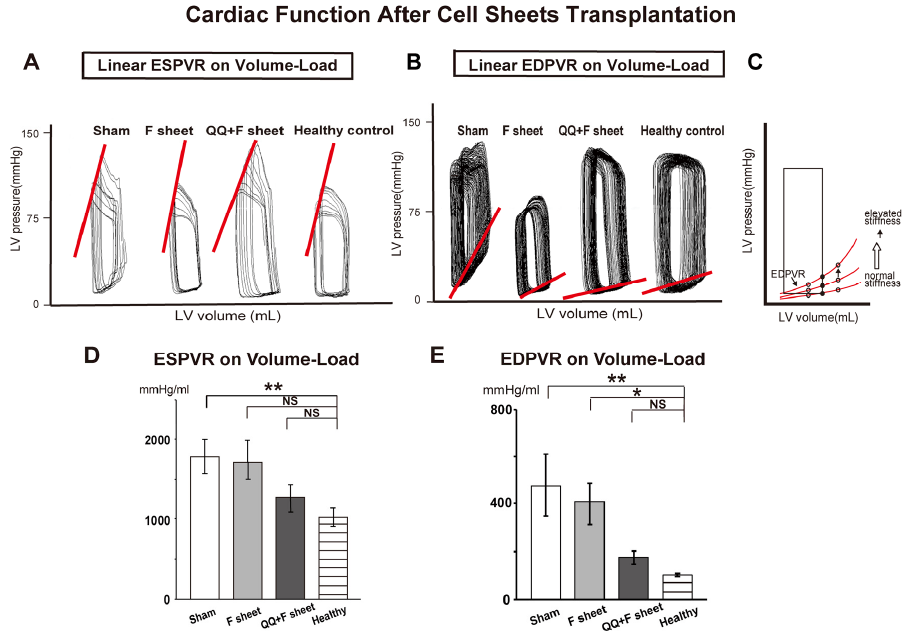
Figure 6. Cardiac function on 15 days after transplantation of QQ+F sheets derived from EAM rats. Cardiac functions were recorded using a conductance catheter and the pressure–volume (P-V) loop was measured as described in Methods. ( A , B ) Representative P-V loops on 14 days after cell sheet transplantation. ( A ) The oblique lines indicate end-systolic pressure–volume relationship (ESPVR). ( B ) The oblique lines indicate end-diastolic pressure–volume relationship (EDPVR). ( C ) An sche- matic diagram showing hypothetical EDPVR. EDPVR describes LV compliance. A decrease in LV diastolic function owing to a decrease in cardiac compliance is indicated by an upward shift in EDPVR. ( D ) The ESPVR on volume load showed significant differences between sham and healthy control groups. N = 6 rats per group. ( E ) The EDPVR on volume load were significantly higher in the sham and F-sheet groups than in the healthy control group. There was no significant differences between the QQ+F sheet and healthy control groups. N = 6 rats per group. Data are shown as mean ± SE. NS, not significant, * p < 0.05, ** p < 0.01, vs. healthy control group. 3.6. QQ+F Sheets Grafts in EAM Hearts Inhibited the Bnp Gene Expression Indicating HF BNP is considered a diagnostic and prognostic biomarker for HF [37]. Bnp mRNA levels in the heart at 14 days after sheet transplantation were significantly higher in the sham and F-sheet groups than in the healthy control group ( p = 0.012 for vs. sham, p = 0.030 for vs. F-sheet; Figure 7). However, there was no significant difference between the QQ+F sheet transplant and the healthy control group ( p > 0.05). The findings indicate that QQ+F sheet grafts in EAM hearts did not improve systolic cardiac function, but main- tained healthy diastolic cardiac function.